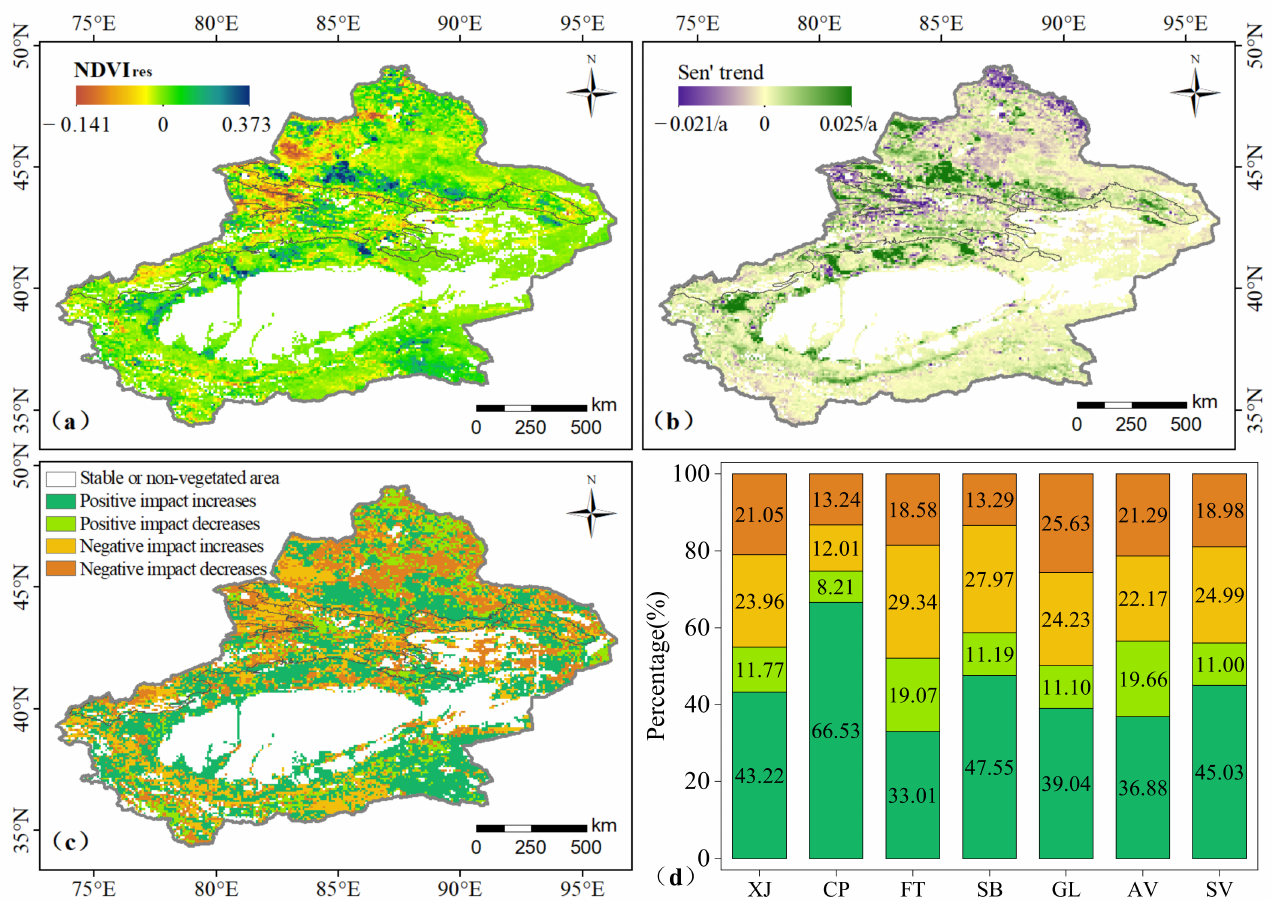
Figure 5. Change trends of NDVI res from 2000–2018. ( a ) Spatial pattern of NDVI res ; ( b ) annual change trends; ( c ) types of change trends and ( d ) percentage changes of different vegetation types. The legend of ( d ) is the same as that of ( c ). XJ: Xinjiang; CP: crop; FT: forest; SB: shrub; GL: grassland; AV: alpine vegetation; and SV: sparse